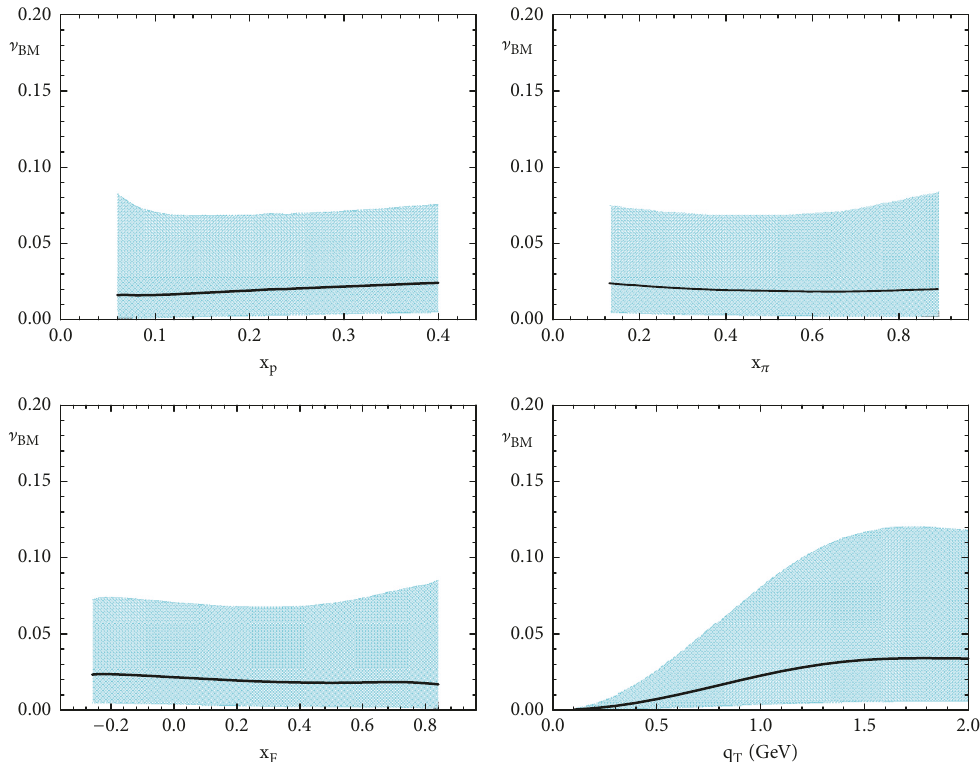
Figure 7: The cos 2𝜙 azimuthal asymmetries ] 𝐵𝑀 as the functions of 𝑥 𝑝 (upper left), 𝑥 𝜋 (upper right), 𝑥 𝐹 (lower left), and 𝑞 ⊥ (lower right) for the unpolarized 𝜋𝑝 Drell-Yan process considering the TMD evolution in the kinematical region of COMPASS. The shadow areas correspond to the uncertainty of the parameters in the parameterization of the Boer-Mulders function for proton in [62]. Figures from [61].